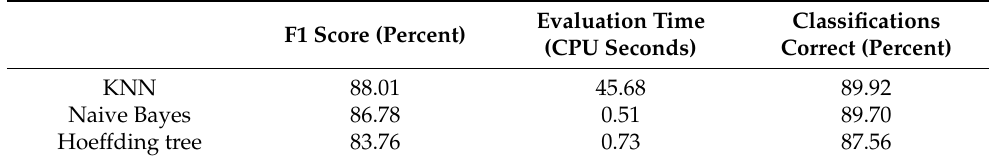
Table 3. General performance of algorithms.